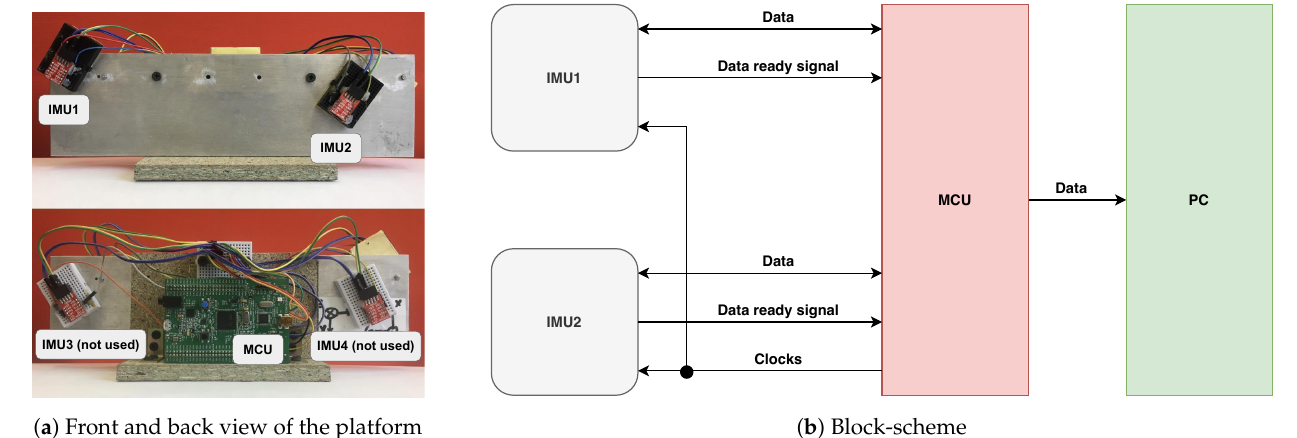
Figure 4. ( a ) Common view of gyroscope-based clock synchronization accuracy estimation system. Only two IMUs and MCU board are used. ( b ) Block scheme of the system. Signals transfer direction denoted by arrows directions.